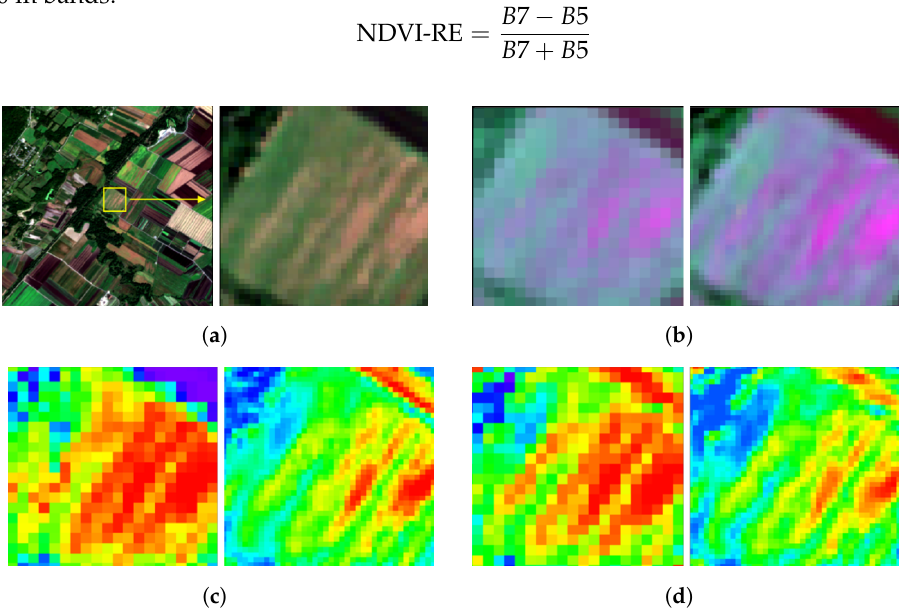
Figure 9. Comparison of vegetation indices using the 20 m bands with and without super-resolution (Sentinel-2 image of 28 September 2017, New York, U.S.A.). ( a ) Agriculture zone (RGB) (left: full scene, right: zoom-in); ( b ) Agriculture zone {B12,B8A,B11} (Left: 20 m GSD, right: SR (10 m GSD); ( c ) NMDI Index (left: original bands, right: SR bands); ( d ) NDVI-RE index (left: original bands, right: SR